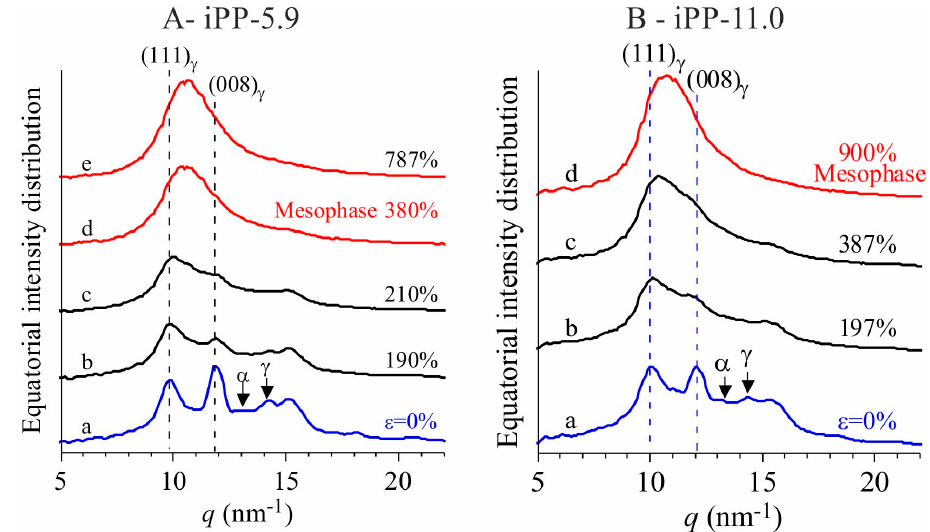
Figure 2. Equatorial profiles extracted from the bidimensional WAXS images of Figure 1 for the samples iPP-5.9 ( A ) and iPP-11.0 ( B ). The relevant reflections of α and γ forms are indicated.